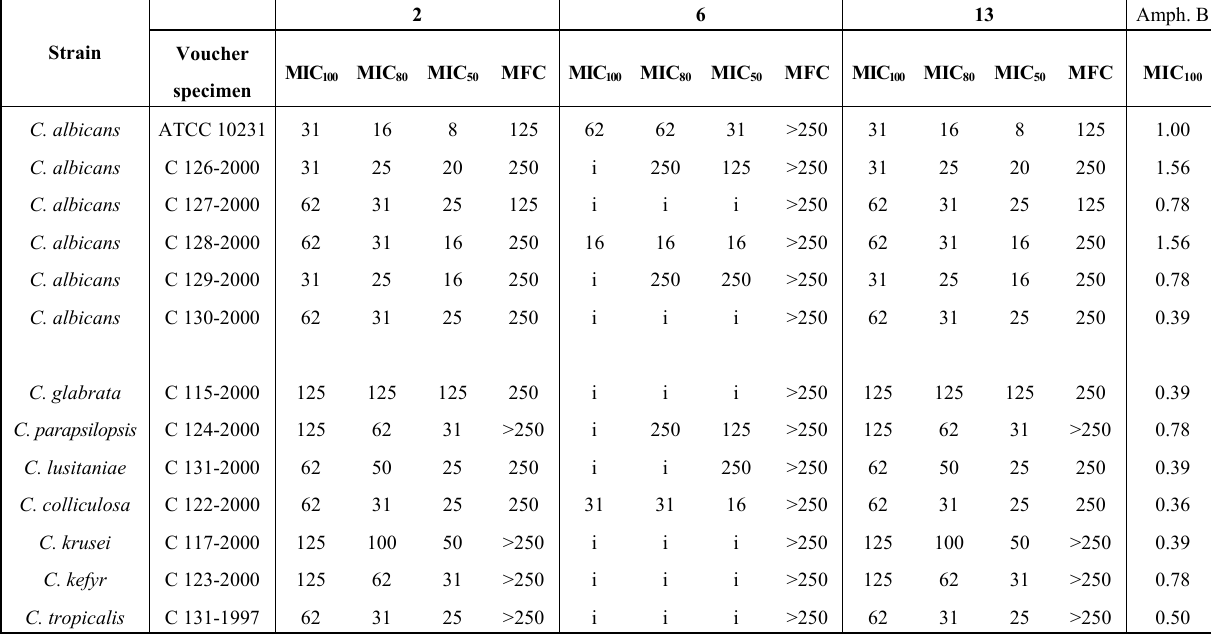
Table 2. Minimum Inhibitory Concentrations (MIC Fungicidal Concentration (MFC), in µg mL − 1 of 2 , 6 and 13 against clinical isolates of C . albicans and non- albicans Candida spp. For the sake of comparison the MIC and MFC of all compounds against an ATCC standardized strain of C. albicans was